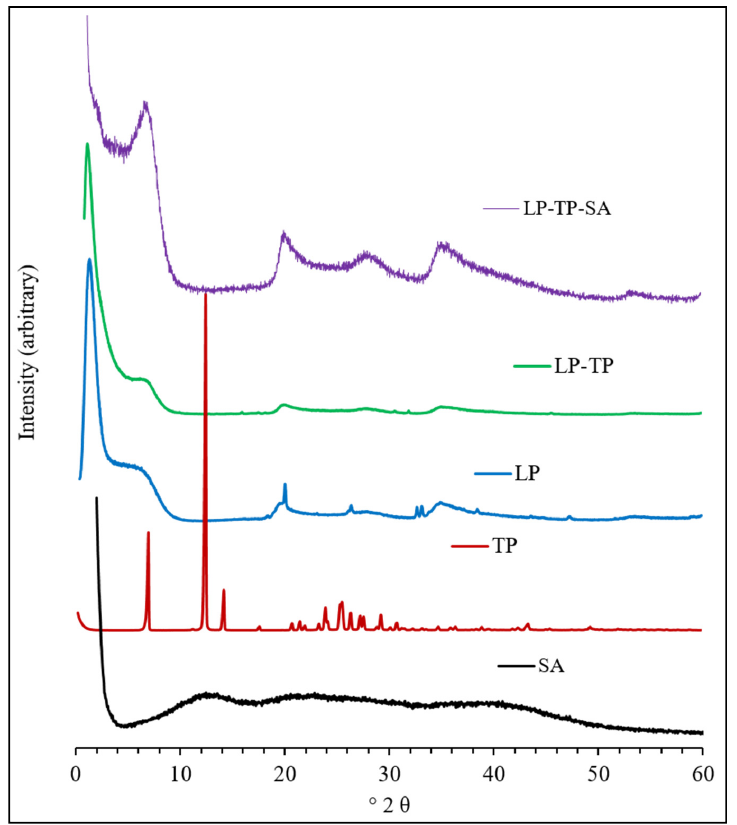
Figure 7. Diffractograms of sodium alginate (SA), TP, LP, LP-TP and LP-TP-SA. Figure 7. Di ff ractograms of sodium alginate (SA), TP, LP, LP-TP and The diffractogram of pure LP is characterised by reflections at 6.8°, 20.1°, 26.4°, 35.4°, 61.3° and 71.4°. The broad basal reflection at 6.8° denotes poor organisation of the clay layers in the c -axis direction, with a mean interlayer spacing of 12.9 Å. The diffraction pattern of TP closely resembles those reported in the literature and indicates that the material used in this study is pure crystalline anhydrous TP [18]. Conversely, reflections of TP were not present in the diffractogram of the binary LP-TP hybrid, which demonstrated that it was present in an amorphous form. An increase in the basal spacing of LP from 12.9 to 14.4 Å, following uptake of TP, confirmed that the drug was intercalated between the clay sheets [20,21]. No other changes in the diffraction pattern of LP were observed, which indicated that the crystalline structure of the individual LP sheets remained unaffected after drug intercalation. The diffraction pattern of sodium alginate used in this study had no distinct reflections, indicating that this polymer was amorphous. The ternary LP-TP-SA composite showed peaks similar to those of the pure LP, demonstrating that in-situ intercalation of alginate into the clay did not occur during the formation of the beads. ATR-FTIR spectra of LP, TP, SA, LP-TP and LP-TP-SA are shown in Figure 8. The spectrum of LP shows a broad peak centred at 3445 cm − 1 that arises from the O-H stretching vibrations of structural silanol groups (-Si-OH) and interlayer water molecules; the band at 1640 cm − 1 is assigned to the bending modes of water [22,23]. The sorption band at 990 cm − 1 is due to the Si-O stretching vibrations, and the bands at 650 and 434 cm − 1 correspond to Mg-O-Mg and Si-O-Mg bending.